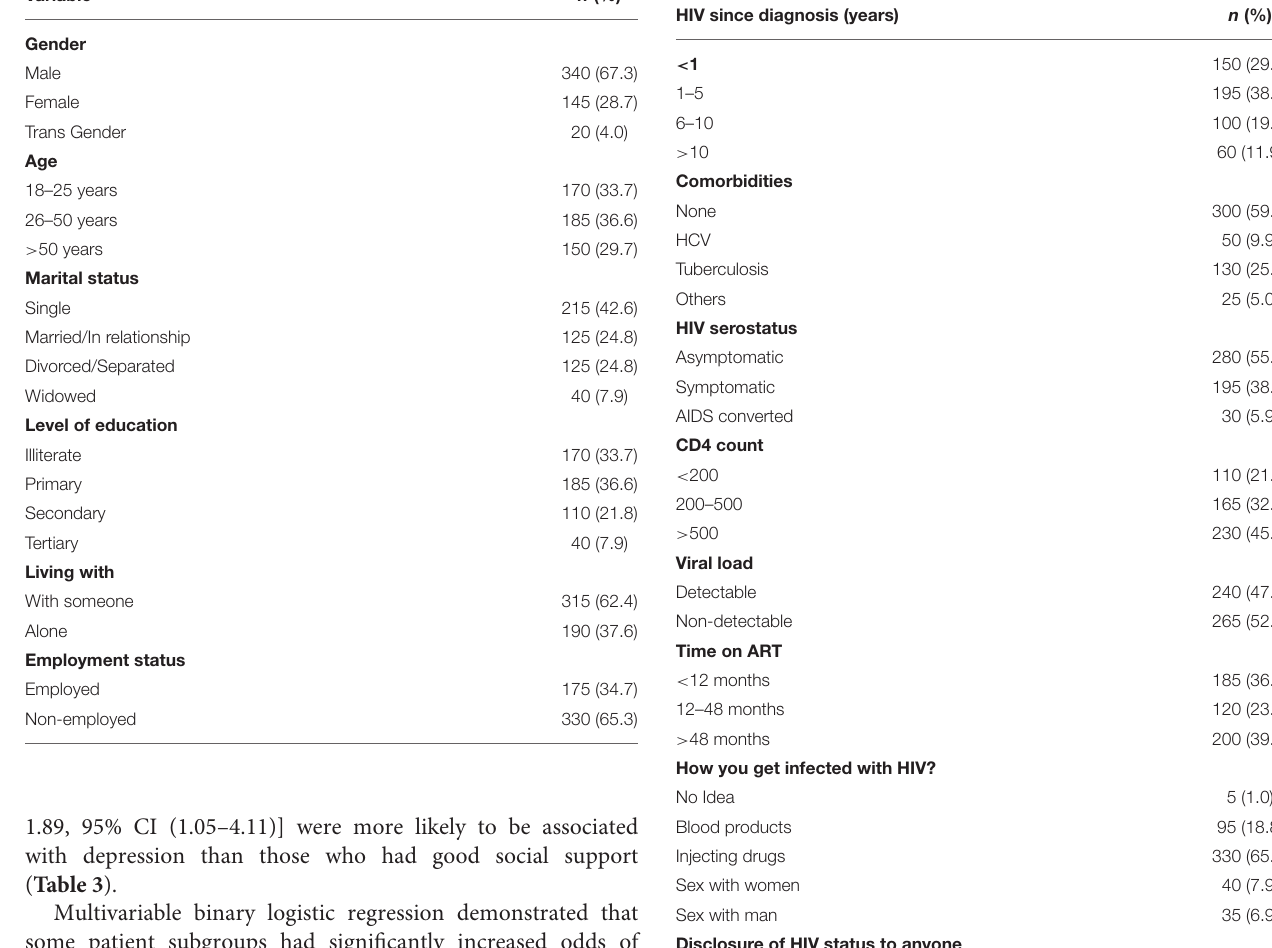
TABLE 1 | Sociodemographic characteristics of people living with HIV/AIDS. Variable